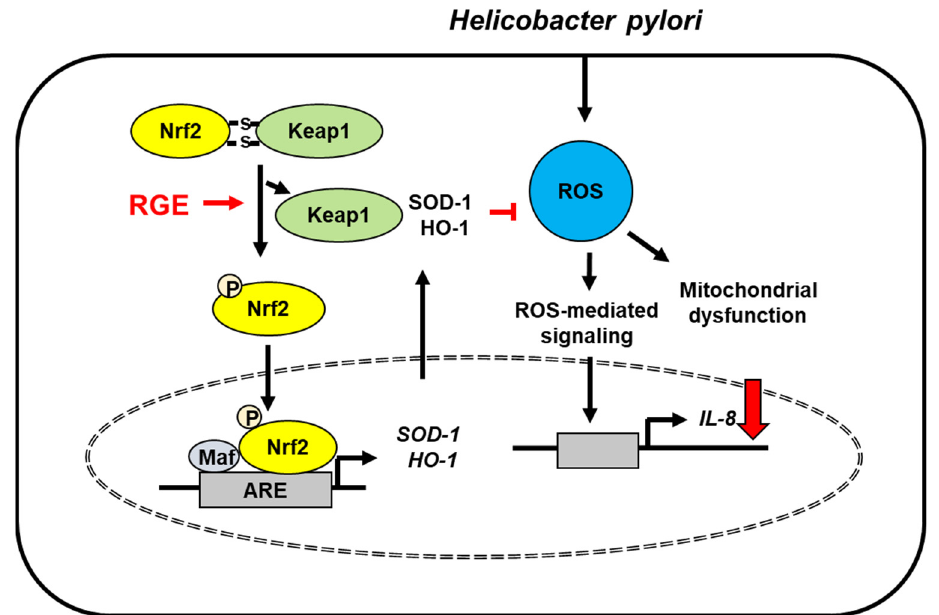
Figure 6 . The proposed mechanism underlying the inhibitory effect of RGE on IL-8 expression in Helicobacter pylori -stimulated gastric epithelial cells. Helicobacter pylori increases ROS levels, which induces mitochondrial dysfunction and reactive oxygen species (ROS)-mediated signaling, leading